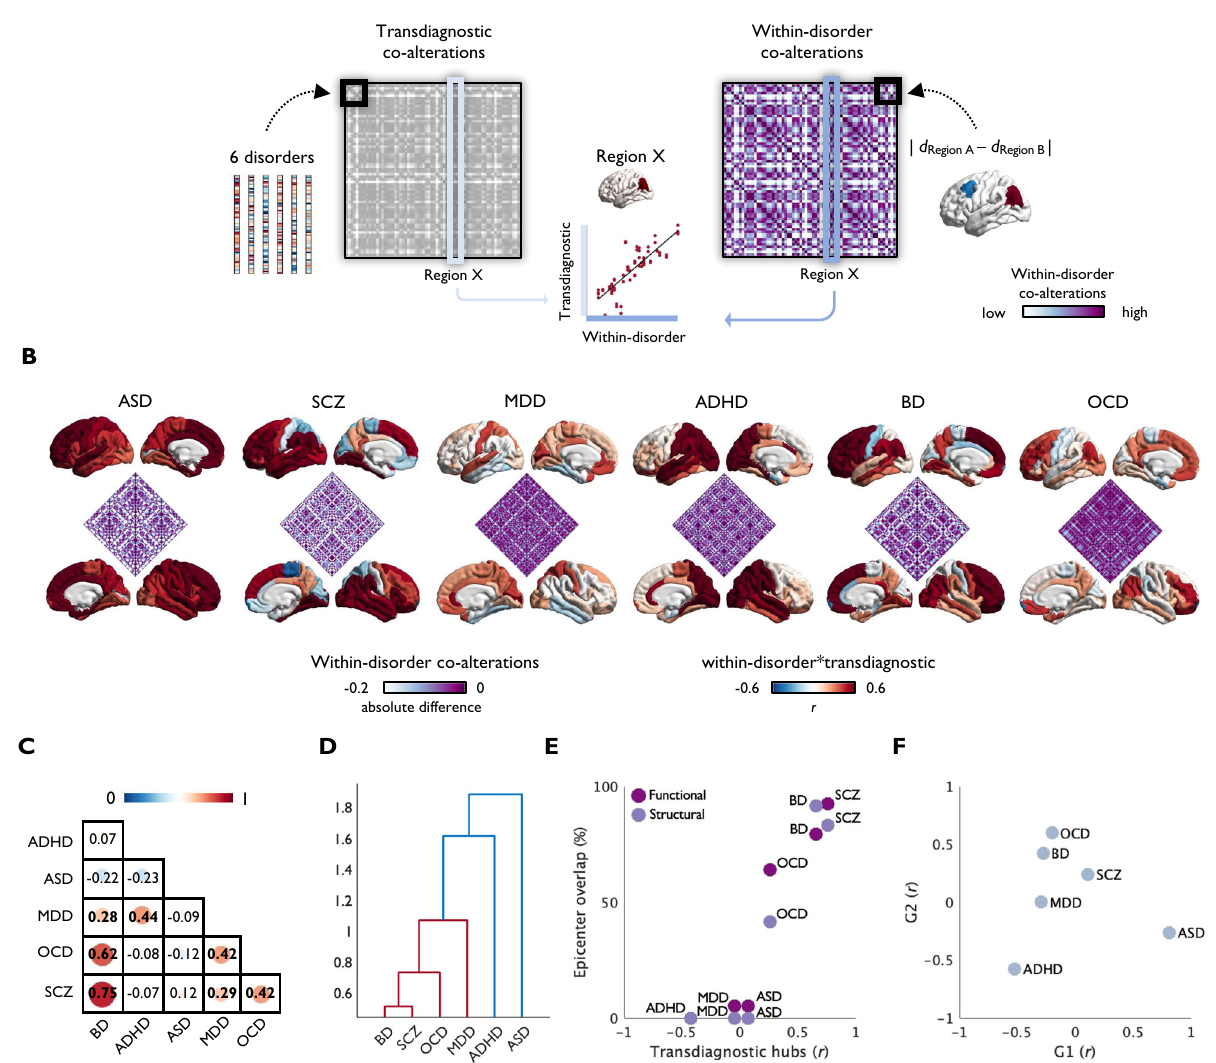
Fig. 3 | Embedding of six disorders within transdiagnostic co-alteration net- works. A Computation of transdiagnostic and within-disorder co-alteration matrices. B Region-wise correspondence between disorder-speci fi c and trans- diagnostic co-alteration pro fi les. Disorder-speci fi c inter-regional difference scores were inverted so that higher correlations with transdiagnostic patterns indicate higher coupling. C Similarity of illness effects between disorders, i.e., correlations of Cohen ’ s d maps, and how they cluster together in a two-cluster solution ( D ).